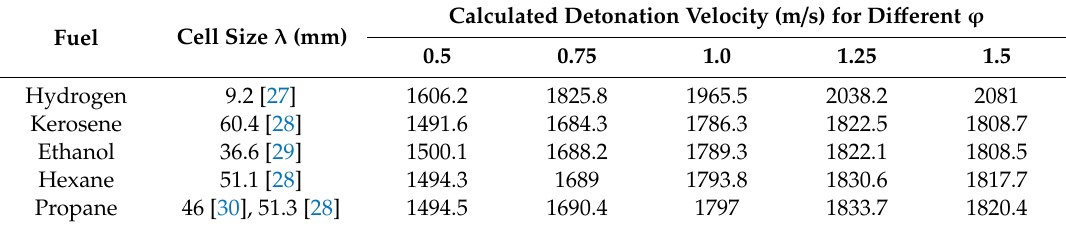
Table 4. Cell size and calculated detonation velocity for 293 K initial temperature equal and 100 kPa initial pressure of fuel–air